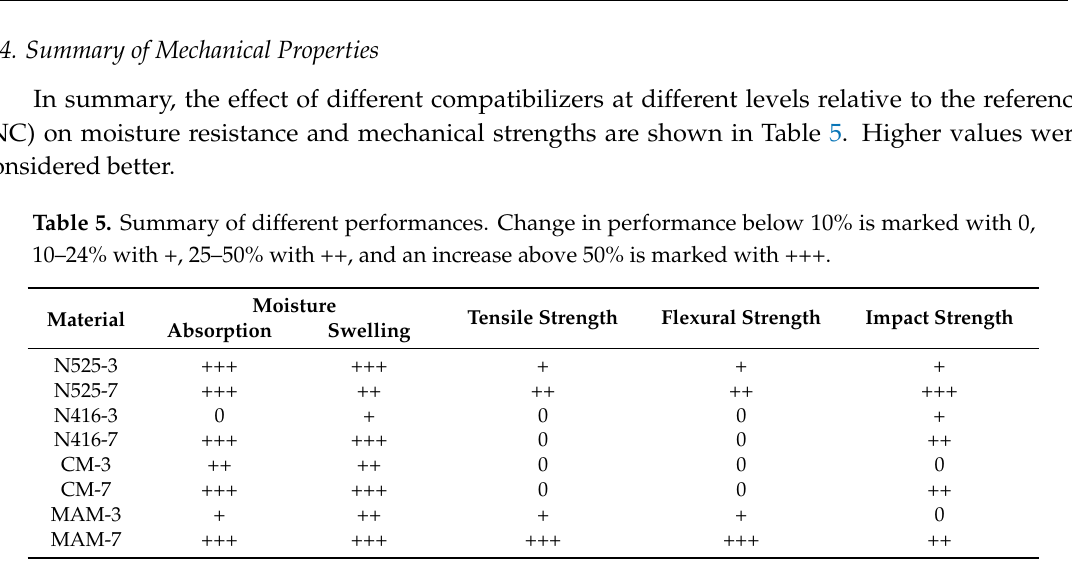
Table 6. Physical properties of commercial WPCs and two produced. N/A denotes not available.